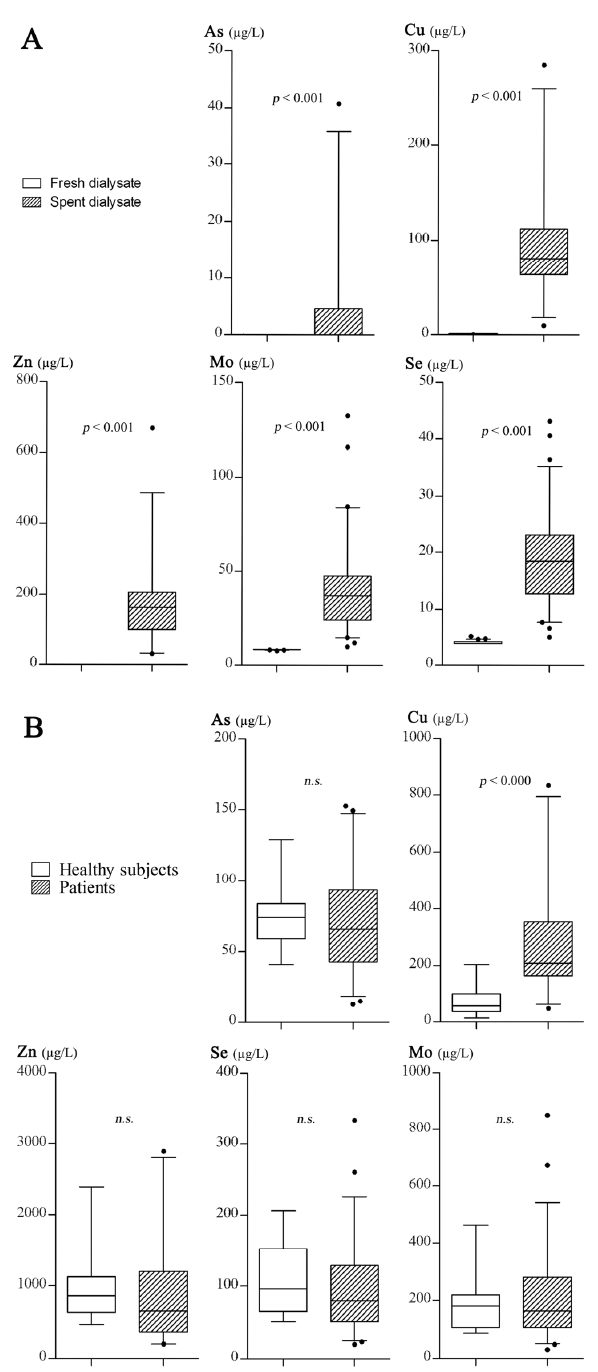
Figure 1. ( A ) The comparison of trace element concentrations between fresh and spent dialysate (effluent); ( B ) The comparison of urinary trace element concentrations between patients and healthy subjects. n.s.: no significant difference.